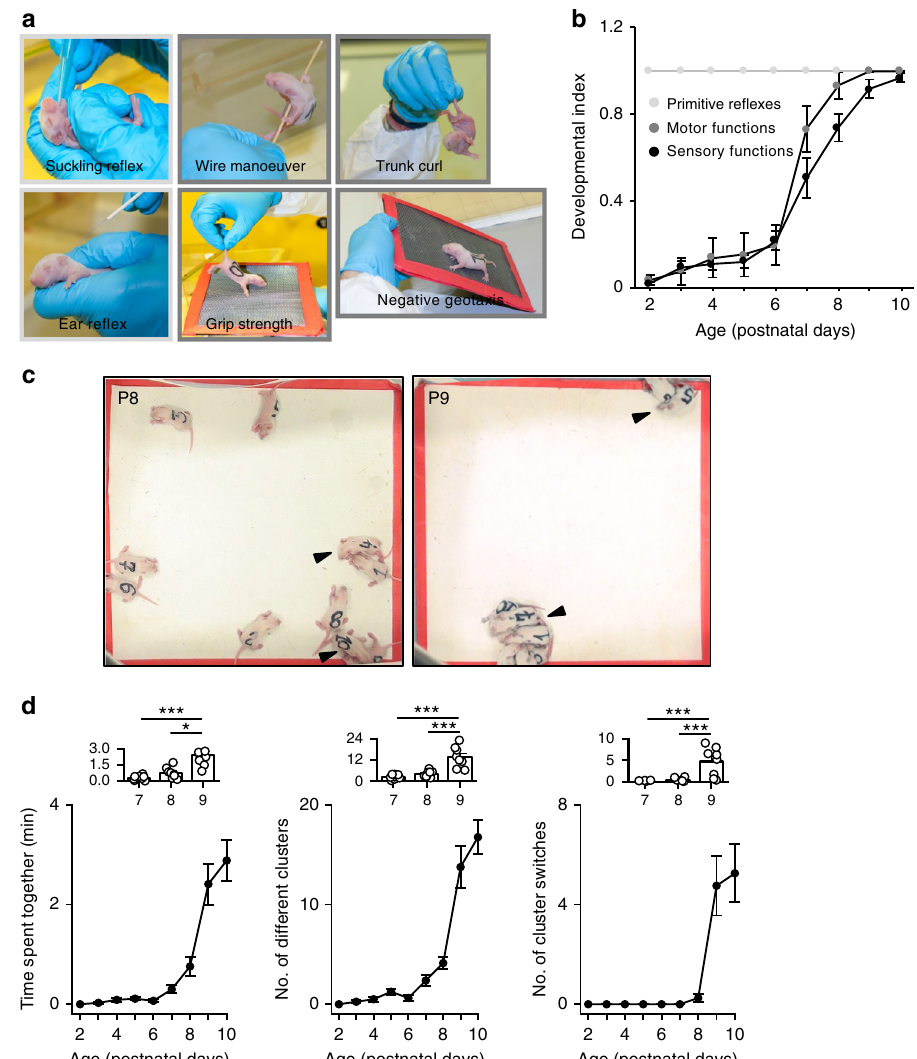
Fig. 2 Huddling behavior develops at the beginning of the second postnatal week, whereas primitive re fl exes and motor and sensory functions develop earlier. a Representative images showing the primitive re fl exes and motor and sensory functions, which are color-coded as described in b . b Developmental indexes for primitive re fl exes (light gray) and motor (dark gray) and sensory functions (black) ( N = 80 animals from 8 litters). c Representative images of huddling behavior of animals of different ages when experimental sessions ended. Black arrowheads indicate individual clusters. d Quanti fi cation of the average litter values ± SEM for the three parameters (time spent together, no. of different clusters, and no. of cluster switches), see the methods for the quanti fi cation of huddling behavior. Left panel: Kruskal – Wallis test, χ 2 (2) = 16.3, P < 0.001, post hoc Dunn ’ s test with Holm ’ s correction; middle panel: one- way ANOVA, F (1,22) = 22.8, P < 0.001, pairwise t -test comparisons with Holm ’ s correction; right panel: type II ANOVA of ranks, F (1,22) = 13.2, P < 0.001, h3- corrected. Top inset: average values and single litter data point for P7 – 9 of the data below. * P < 0.05 and *** P < 0.001. Tests shown in b and d were performed on the same set of exhibited a signi fi cant reduction in the mPSCs frequency (2.73 ±